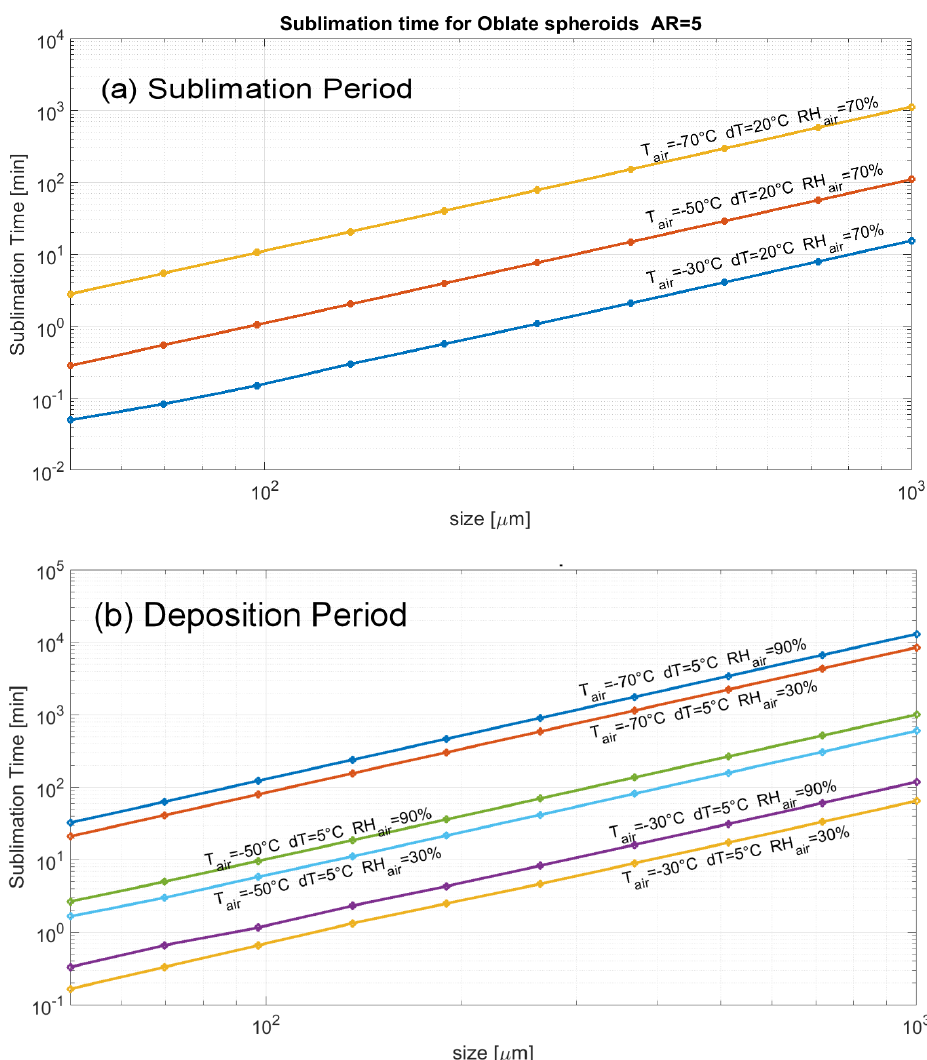
Figure 8. Sublimation time of monodisperse oblate spheroids at varying air temperatures, with (a) d T = 20 ◦ C (sublimation period) and (b) dT = 5 ◦ C (deposition